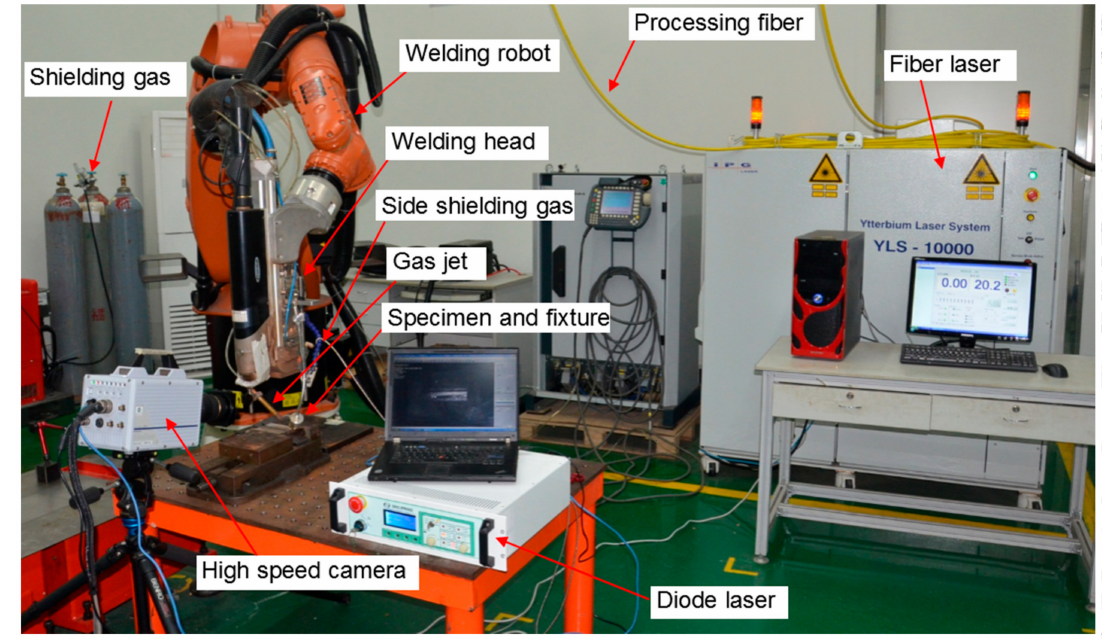
Figure 1. Experimental setup.